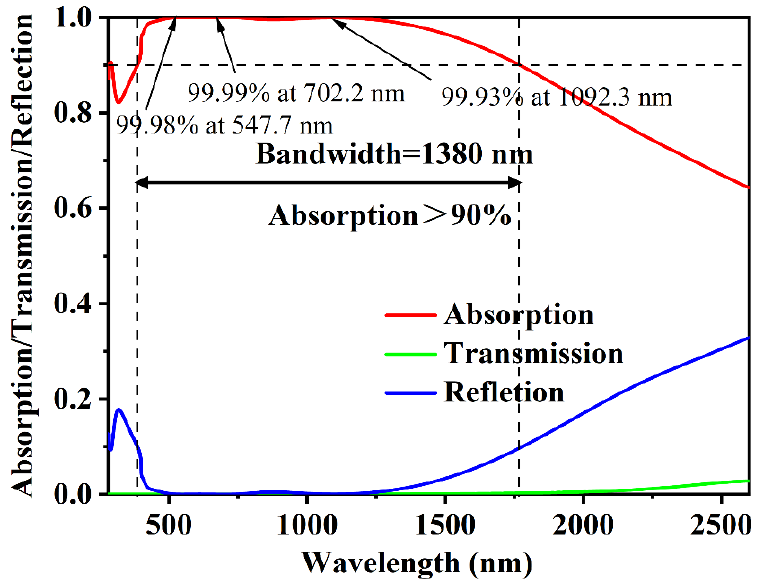
Figure 2. Absorption of cross ellipses broadband absorber.